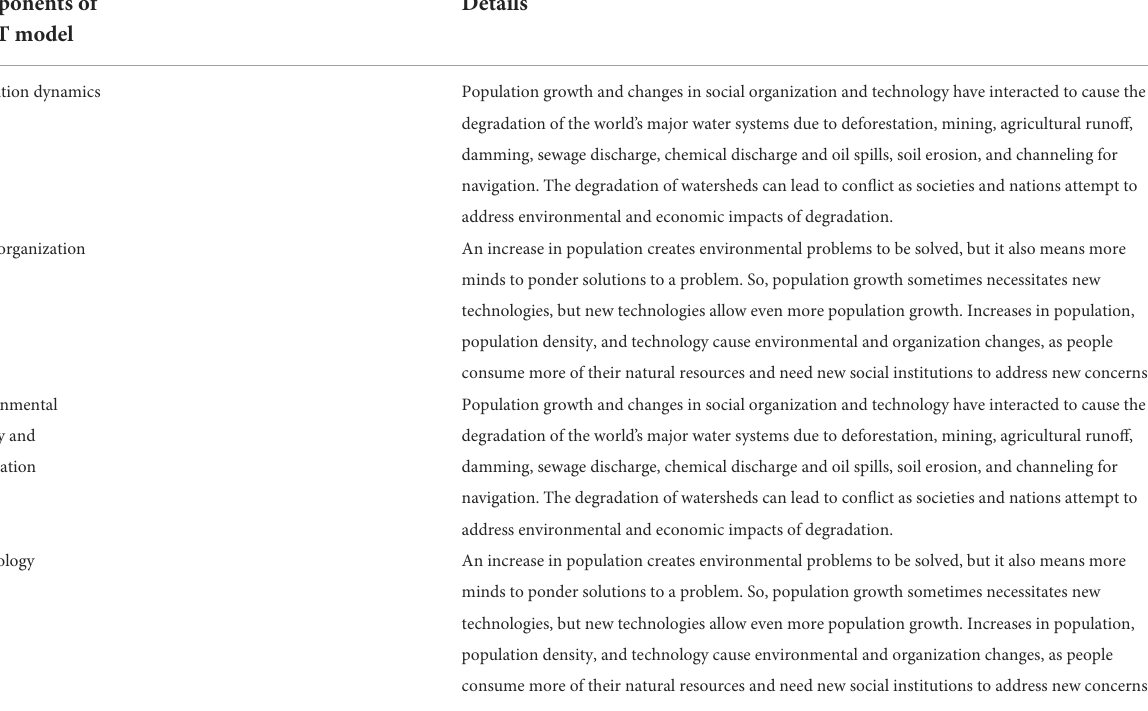
TABLE 1 Components of POET